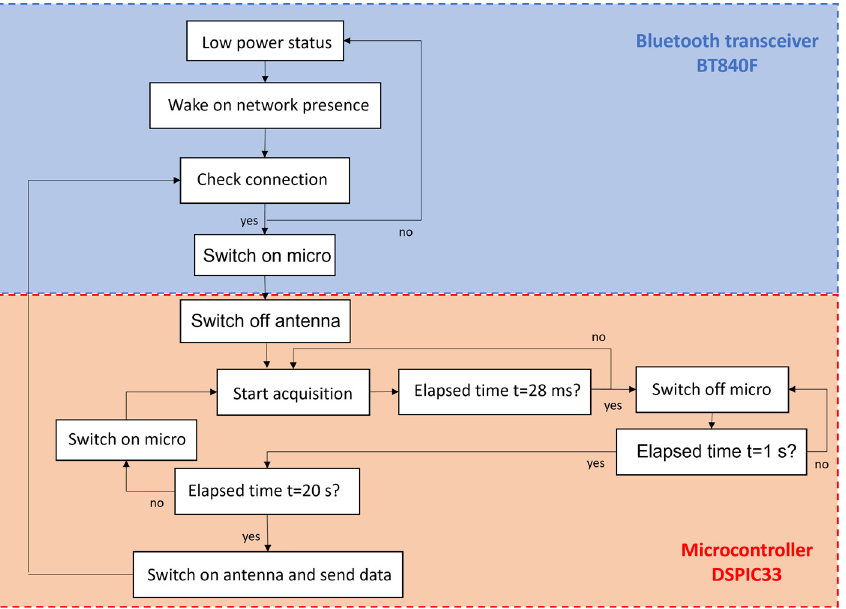
Figure 3. Software architecture and functionalities. The software is implemented on two microcon- trollers: BT840F (blue part) and DSPIC33 (red part).